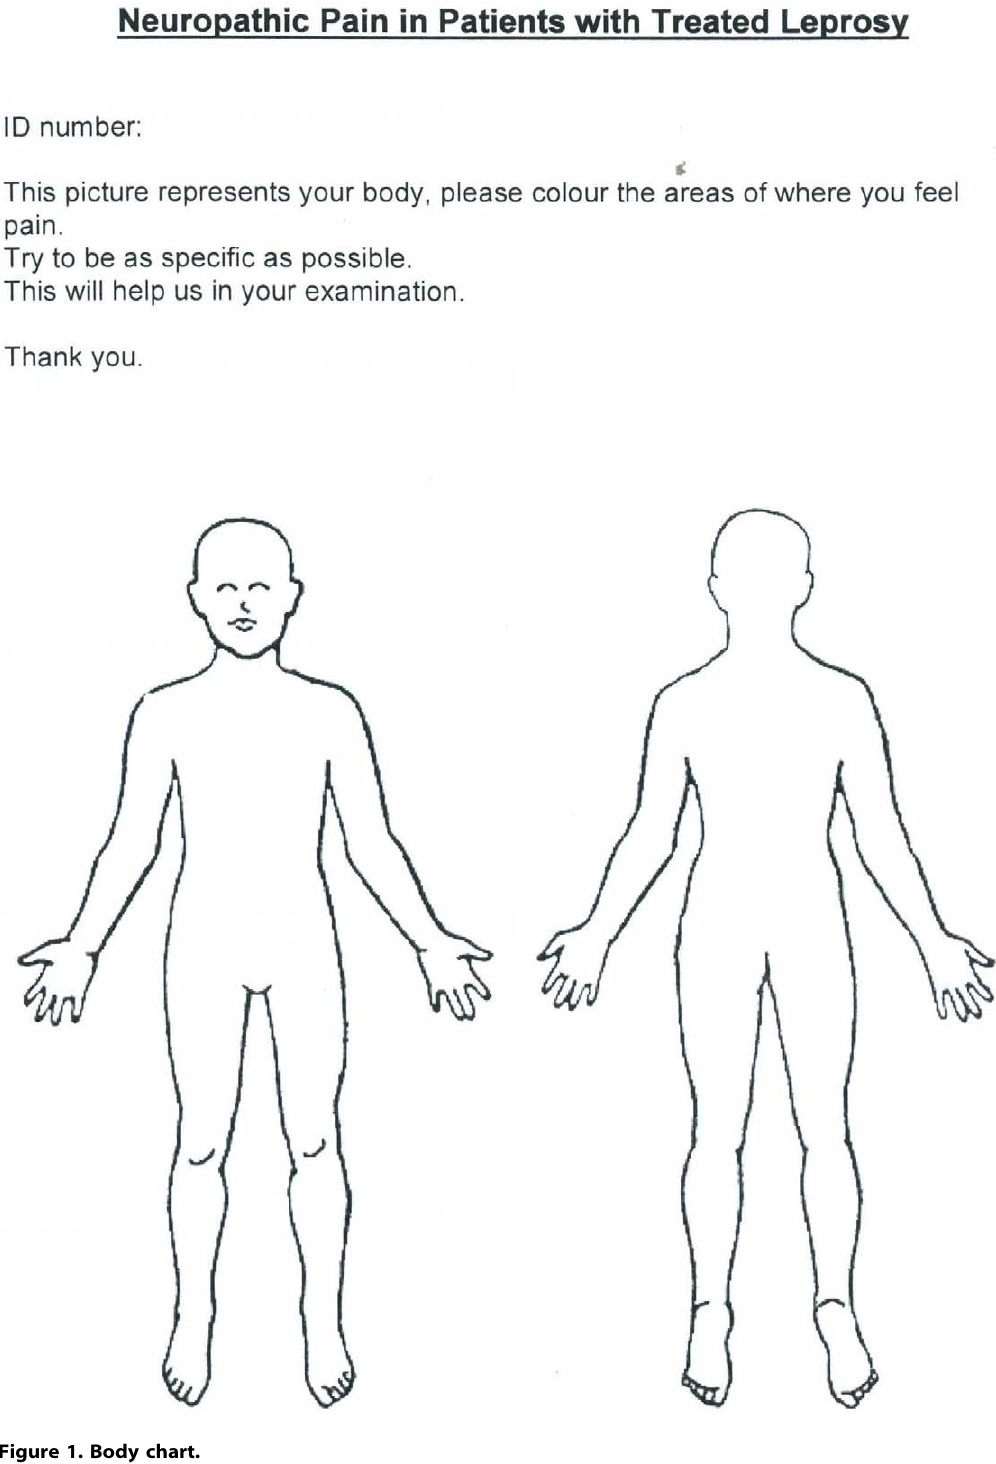
Figure 1. Body chart.